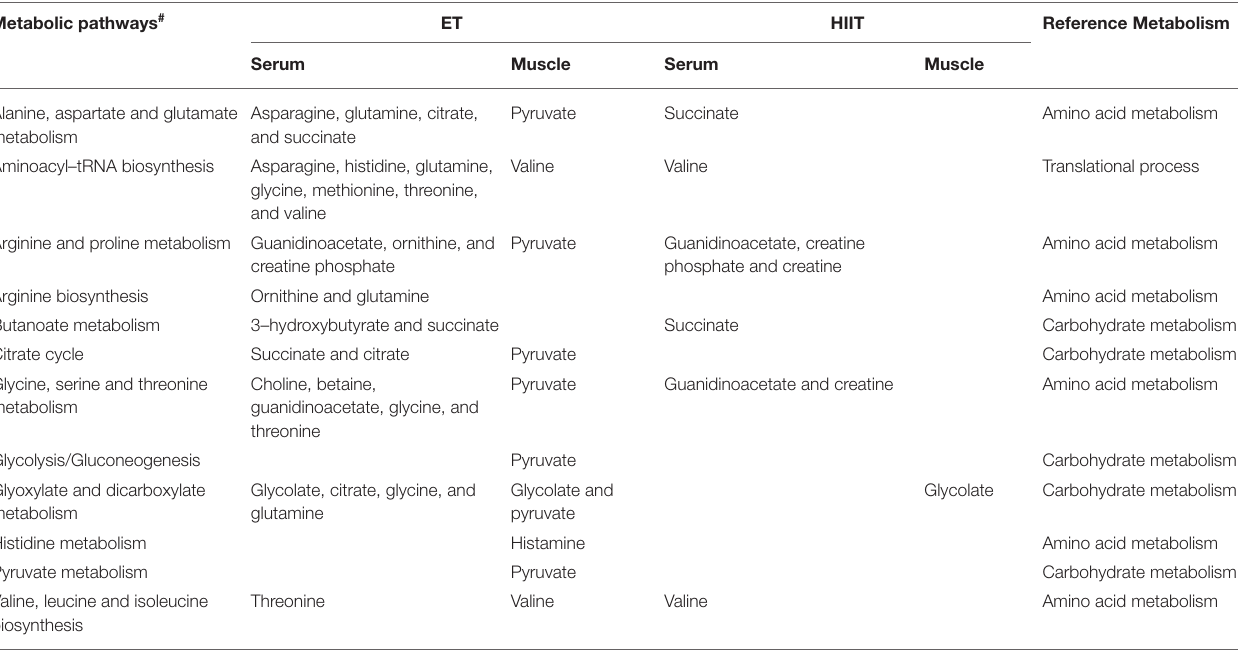
TABLE 5 | Summary of altered metabolites and their metabolic pathways associated with MPO gains in response to ET and HIIT, supported by the three levels of evidence in the TIMES study. Metabolic pathways #